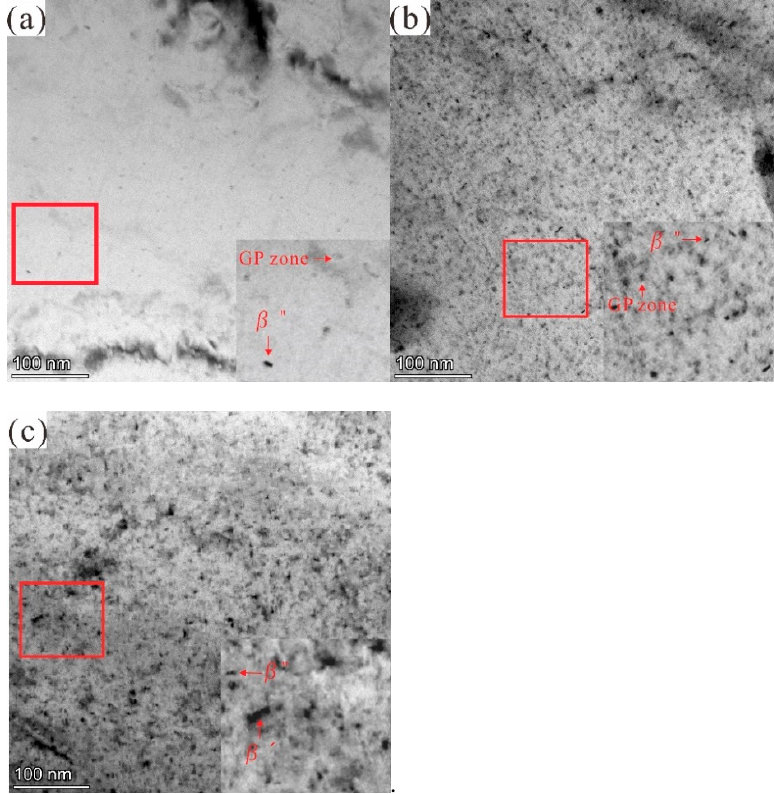
Figure 3. Transmission electron microscopy (TEM) bright-field images of the 6061 aluminium alloy aged at 180 °C for different times: ( a ) 1 h, ( b ) 5 h, ( c ) 14 h.